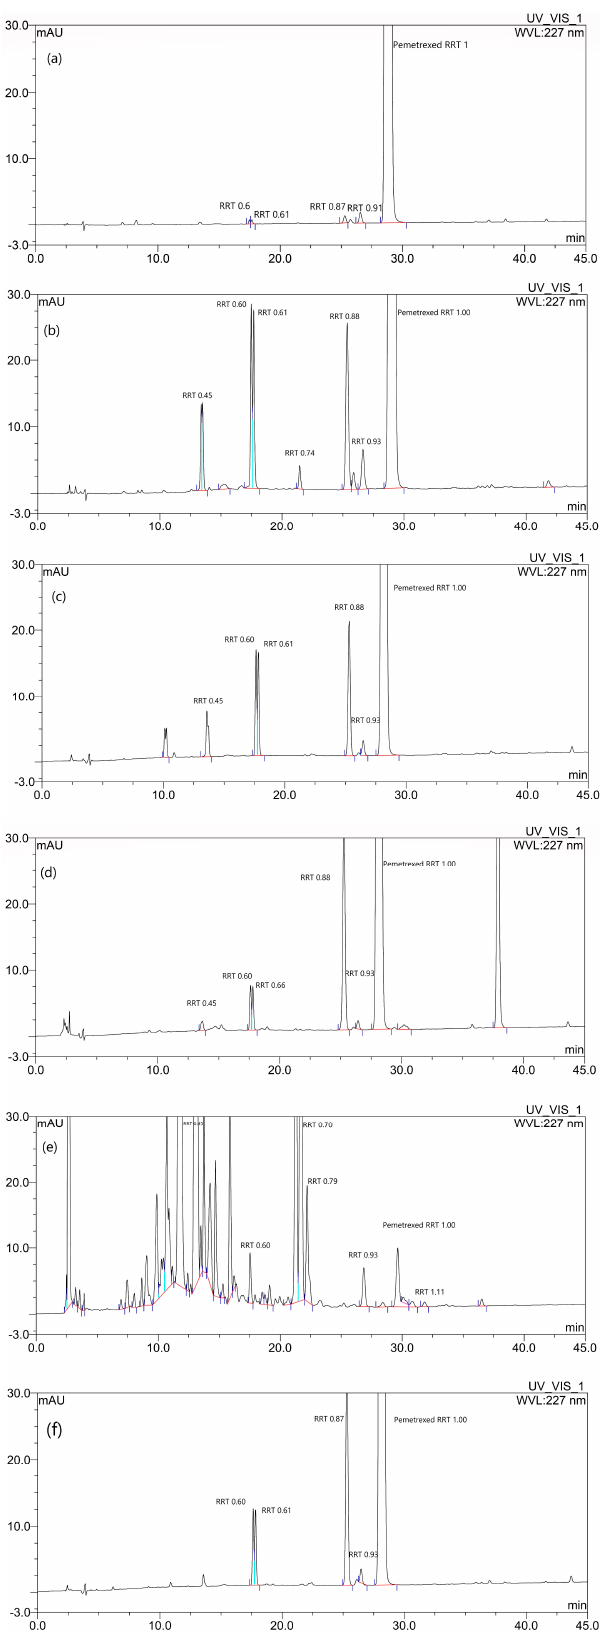
Figure 1. HPLC chromatograms of pemetrexed solution samples: ( a ) initial standard; ( b ) thermal stressed; ( c ) acidic hydrolysis; ( d ) basic hydrolysis; ( e ) oxidation by hydrogen peroxide; and ( f ) photo- oxidation.